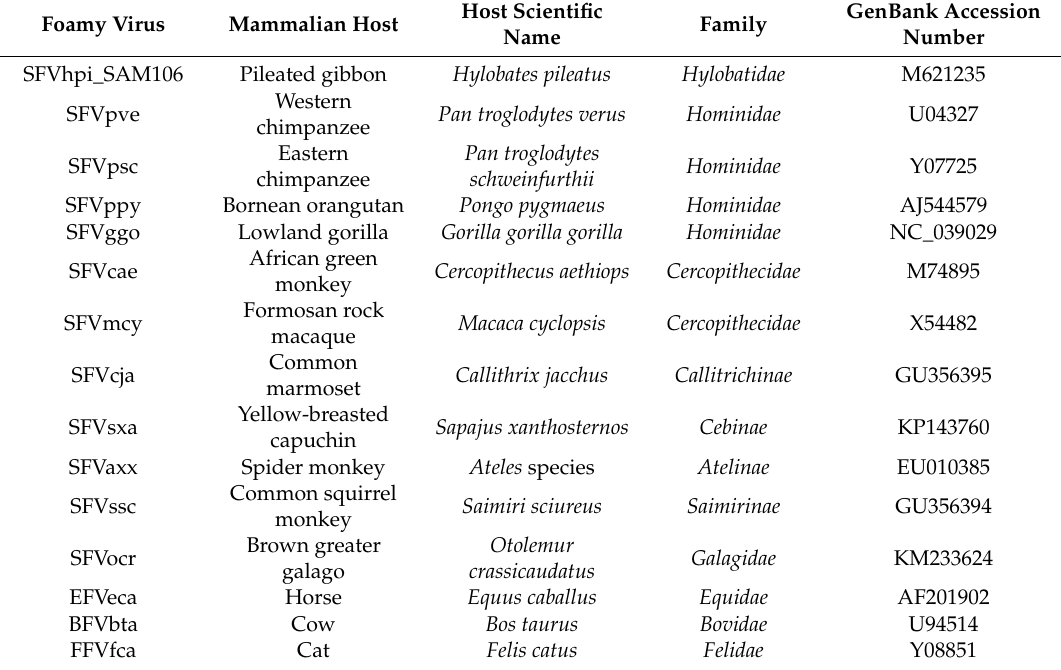
Table 1. Foamy virus complete genomes